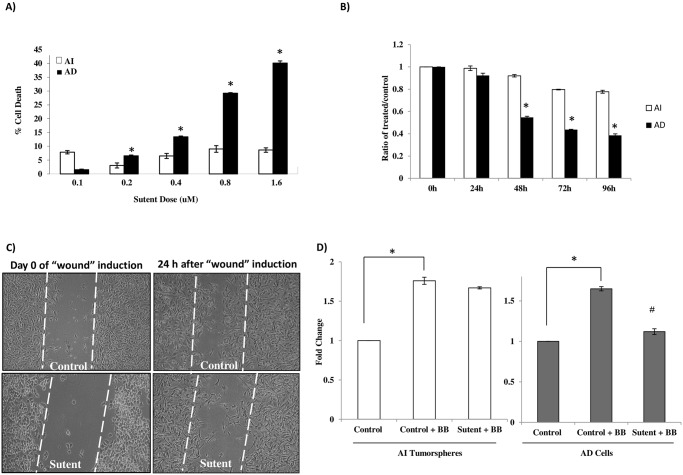
Small molecule inhibition of the PDGFRβ using sutent significantly increases cell death and inhibits cell proliferation and migration in AD cells.(A) NB AI tumorspheres (white bars) exhibited significant resistance to increasing concentrations of sutent treatment compared to un-treated counterparts, as assessed using a cytotoxicity assay after 48 h of treatment, whereas AD cells (black bars) showed a dose-dependent increase in cell death, compared to un-treated counterparts. (B) The average ratio of treated/control absorbance of NB AI tumorspheres and AD cells from four independent experiments run in triplicates was derived and graphed ± SEM. The AI tumorspheres (white bars) were significantly resistant to sutent-induced reduction in cell proliferation compared to their un-treated counterparts over 24, 48, 72 and 96 h post treatment, whereas AD cells (Black bars) showed a marked reduction in cell proliferation after sutent treatment compared to their un-treated counterparts as determined using a WST-1 cell proliferation assay. (C) A “wound-healing” assay was used to assess the PDGF-BB (10 ng) induced cell migration of NB AD cells, treated with sutent for one hour before ‘wound-induction’. Sutent significantly inhibited the AD cells’ ability to migrate into and close the wound after 24 h. (D) A trans-well chemotactic migration chamber was used to measure the PDGF-BB induced cell migration of AD and AI cells that migrated to the underside of the chamber with or without sutent treatment. The average absorbance was represented as a ‘fold-change’ between the groups; unstimulated, untreated cells (Control) were normalized to 1, whereas PDGF-BB induced migration (control + BB) and sutent-induced inhibition of PDGF-BB stimulated migration (sutent + BB) was measured as a fold-change. PDGF-BB stimulation led to a significant (*) increase in AI (white bars) and AD (Grey bars) cell migration compared to their un-stimulated controls. Sutent treatment significantly (#) abrogated (P < 0.05) the PDGF-BB induced AD cells’ (grey bars) ability to migrate to the lower side of the chamber (Fold-change from 1.65 to 1.2), but had only a slight, but not significant (fold-change from 1.75 to 1.65) effect on the trans-well migration capacity of AI tumorspheres (white bars). * indicates a P value < 0.05. Results represent the mean ± SEM of multiple experiments.